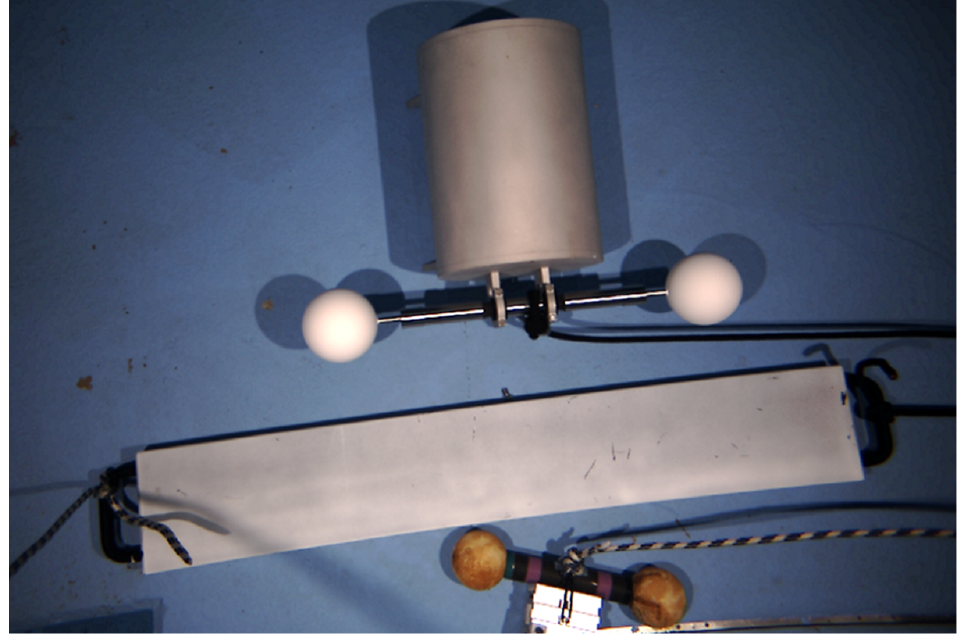
Figure 3. Specimen ball bars, plane-normal, and cylinder during evaluation measurements.